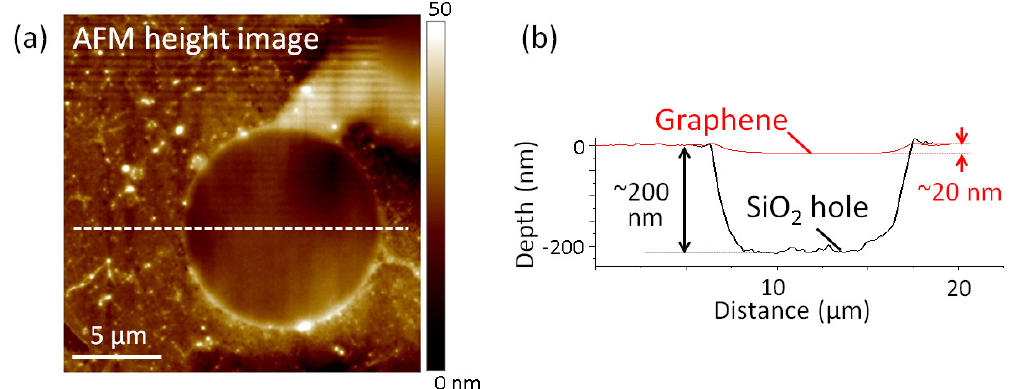
Figure 2. (Color online) ( a ) Atomic force microscopy (AFM) topography of a drumhead graphene resonator. ( b ) Line profile along the dotted line in (a). The red solid line indicates the graphene layer. The black solid line shows the line profile of the hole. Reproduced from [12], with the permission of American Institute of Physics (AIP)